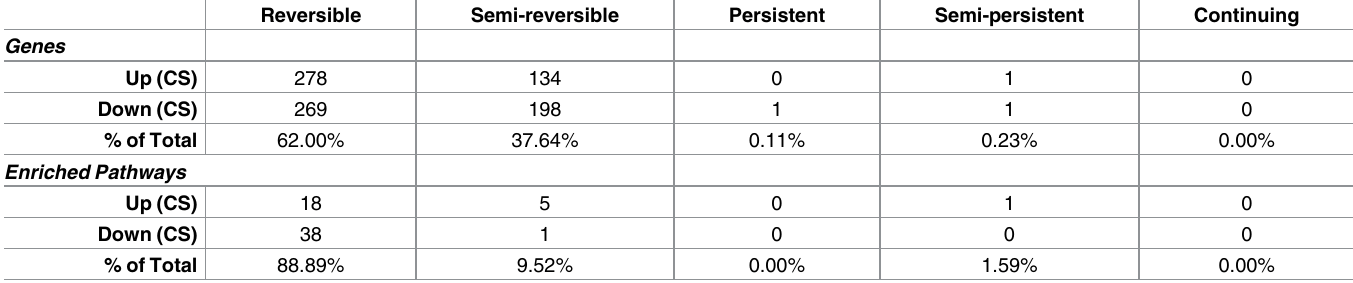
Table 2. Abundance of genes found significantly differentially expressed using edgeR (FDR (cid:20) 0.10) between CS- and AC-exposedmice and enriched pathways using GAGE (FDR (cid:20) 0.10) exhibiting patterns detailed in S1 Fig. Normalization, filtering, and modeling was performed using data from three groups (AC, CS, and smoking